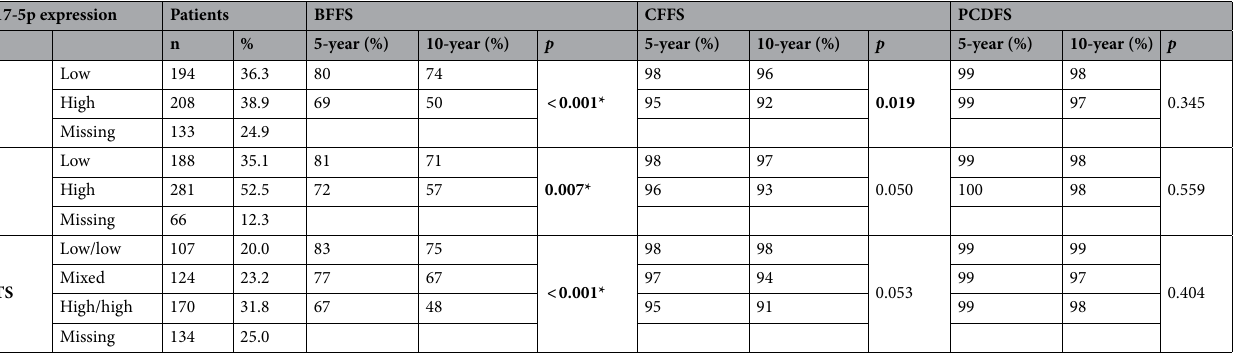
Table 1. Expression of miR-17-5p as predictor for BFFS, CFFS and PCDFS in prostate cancer patients. Univariate analysis; log rank. Significant p-values marked in bold for p < 0.05, and * for p < 0.01. Abbreviations: